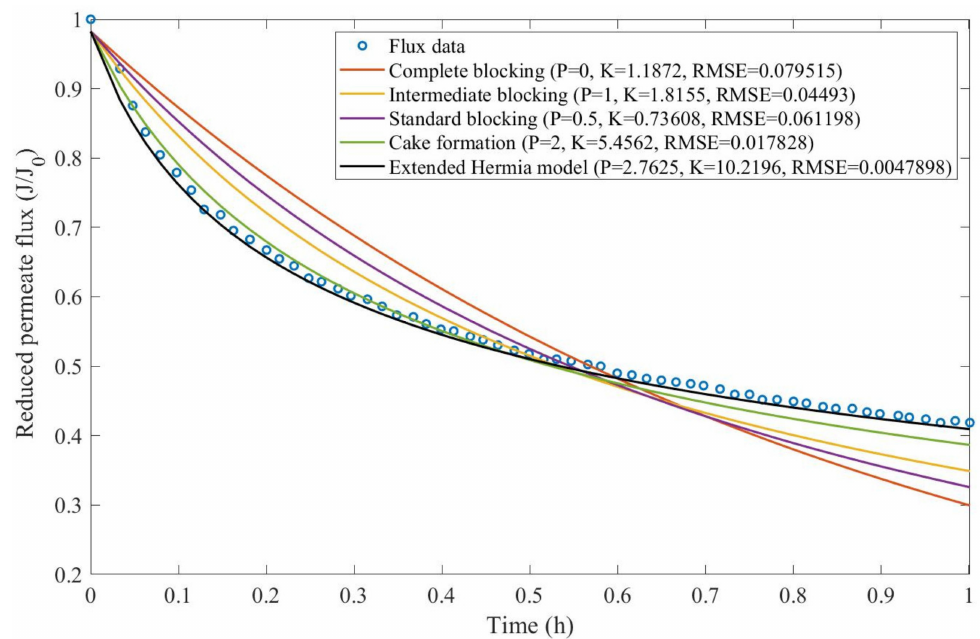
Figure A1. Model fitting for HPI ultrafiltration considering the four original pore-blocking mecha- nisms and the extended Hermia model